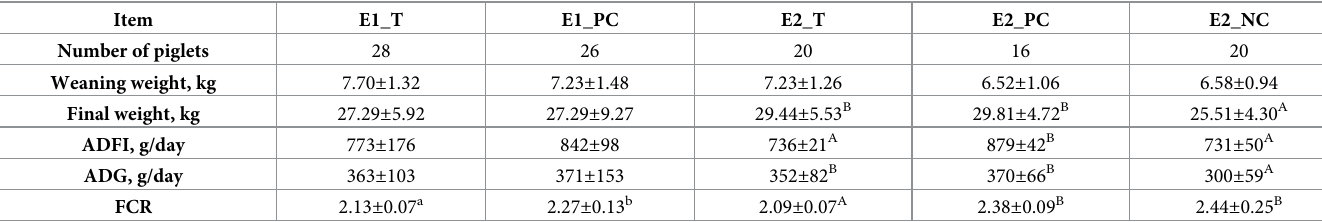
Statistical significance between the groups was determined separately for the two experiments, based on the data measured at the end of the experiments. The experiment ended at days 56 and 63 post weaning for E1 and E2, respectively. a-b Means with the different lowercase letters differ significantly ( P < 0.05) during the E1 experiment. A-B Means with different capitals differ significantly ( P < 0.05) during the E2